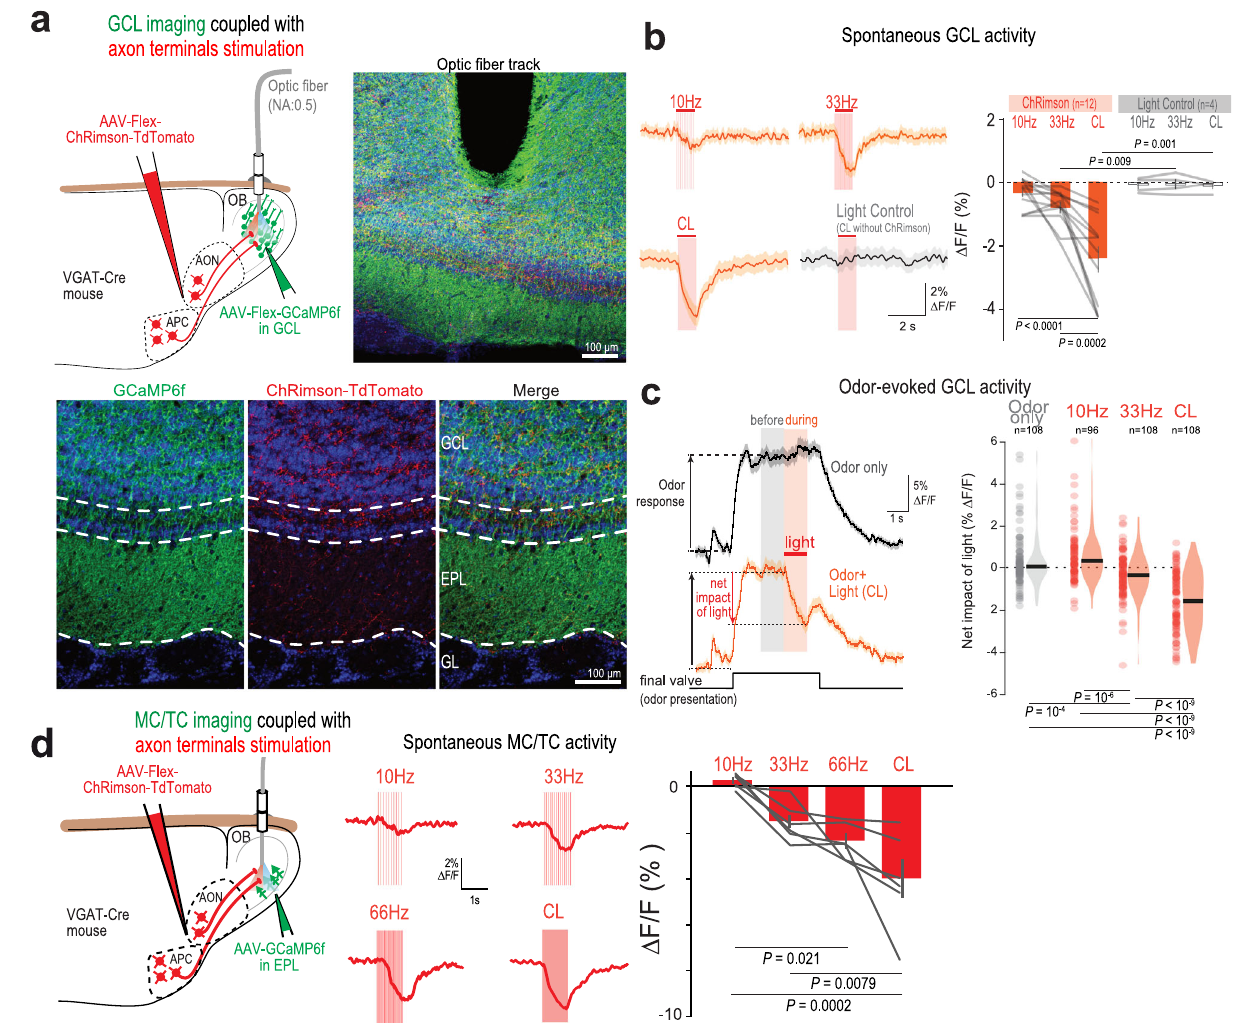
Fig. 4 | Cortico-bulbar GABAergic axons induce net inhibition onto GCL neu- ronsandMC/TCpopulationsinvivo.a CorticalGABAergicaxonswerestimulated in the OB of freely moving mice. Top, Optic fi ber for cortical GABAergic axon optogenetic stimulation (1s) and GABAergic interneuron calcium imaging in the ventralGCL.Bottom,GCaMP6fexpressionacrossOBlayersandChRimsoninAON/ APC GABAergic axons. Blue, DAPI. b Stimulation of cortical GABAergic axons decreased GCL interneuron spontaneous population activity. Left, example trial- averaged responses to different light stimulation patterns. CL continuous light. “ Lightcontrol ” isCLilluminationinmicelackingChRimsonexpression.Right,Mean fl uorescence change in response to light stimulation (RM-One-way-ANOVA with Tukey ’ s post-hoc test, F (2,22)=21.28, P <0.0001). Data presented as mean±sem; gray lines, individual mice. c Stimulation of cortical GABAergic axons decreased GCLinterneuronodor-evokedpopulationactivity.Left, fl uorescencesignalsduring odor presentation only (black) and odor presentation coupled with stimulation of cortical GABAergic axons (orange). Traces are trial-averaged example responses. Mean±sem are represented. Right, Net impact of light on odor responses across